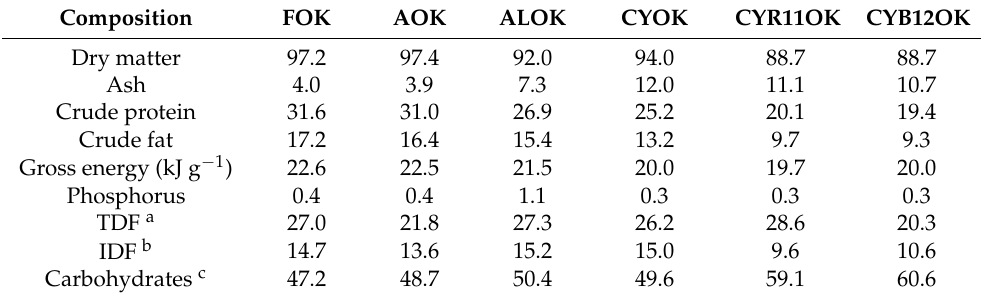
Table 2. Proximate composition (% Dry matter, DM or kJ g − 1 DM) of the test ingredients used in